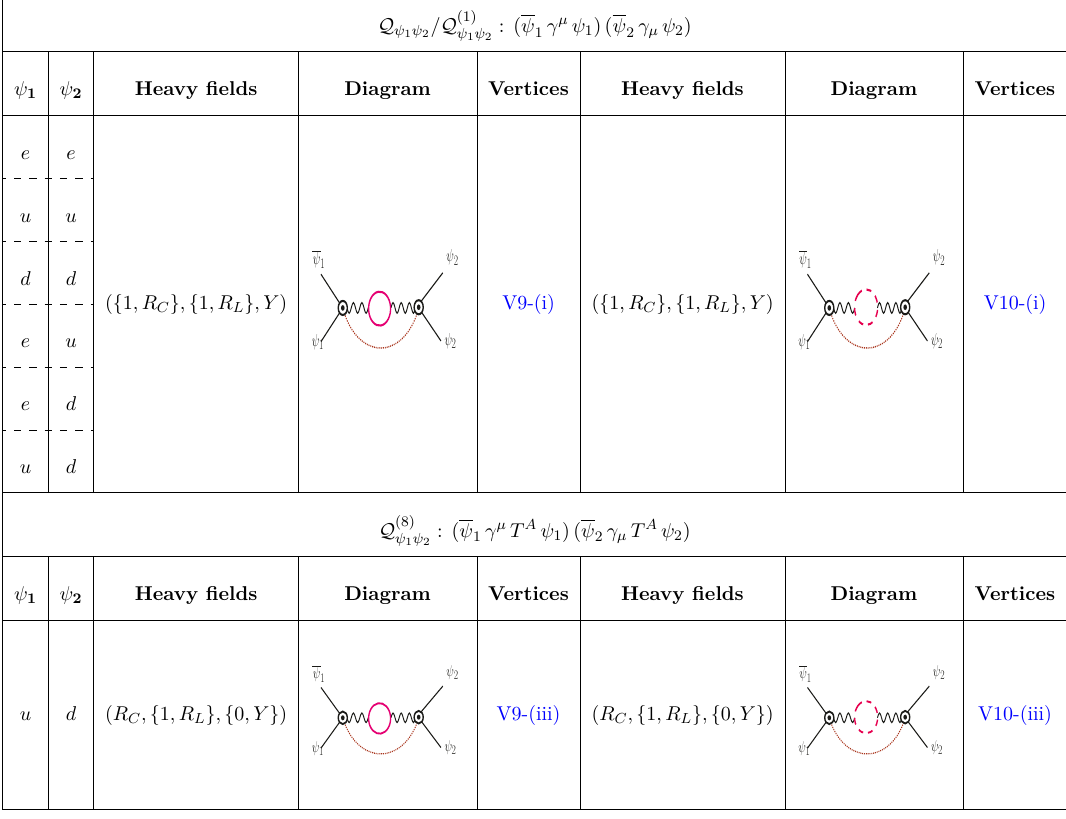
Table 14 . Heavy field representations that are obtained by unfolding the ψ 4 operators, composed of the right chiral SM fermions e , u and d , into non-trivial one-loop-level diagrams and the corre- sponding vertices. In each sub-table, operators with different fermions as external legs but leading to identical heavy field representations through similar diagrams have been grouped together. The headers schematically describe the covariant forms of the